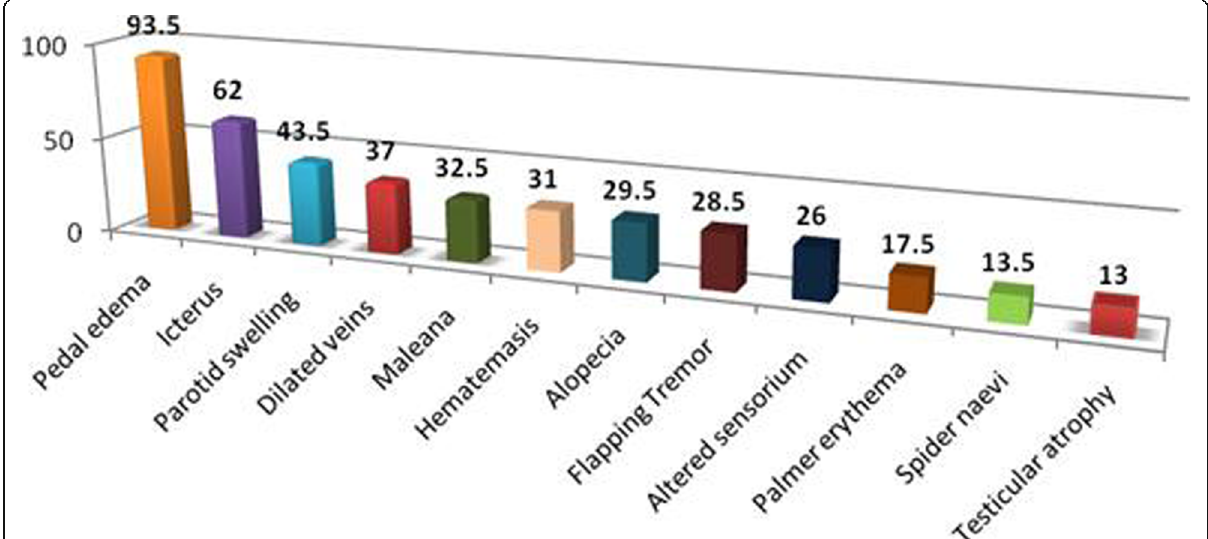
Fig. 2 Symptoms and signs among the cases of chronic liver